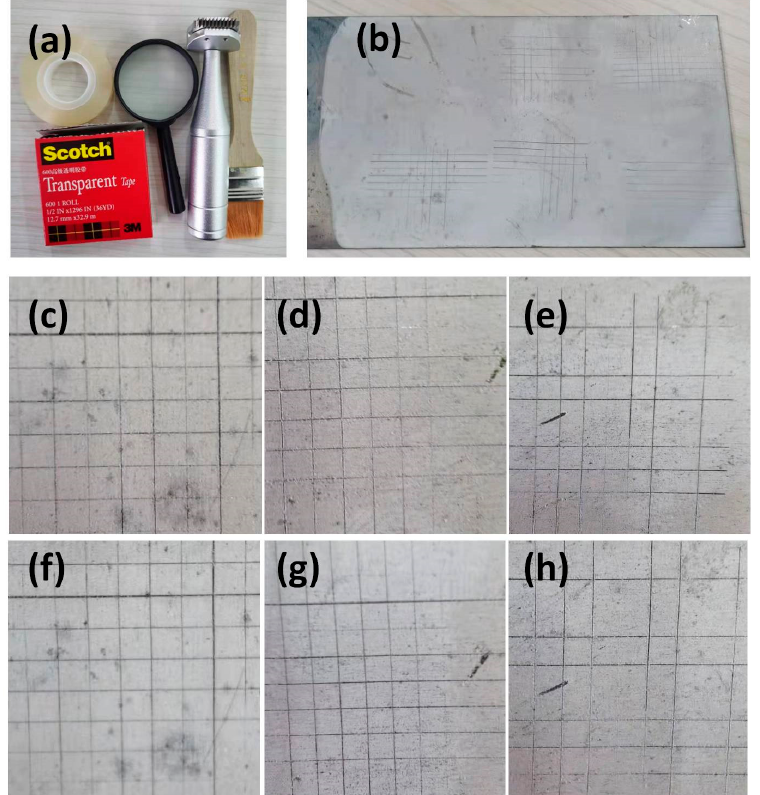
Figure 6. ( a ) Adhesion testing tool. ( b ) The sample of PDMS-SiO 2 /PFA hybrid coating on the aluminum substrate for the test. ( c – e ) The surface diagrams of three different regions after cross cut. ( f – h ) The surface diagrams of three different regions after adhesion and stripping with 3M 600 transparent tape corresponding to ( c – e ).